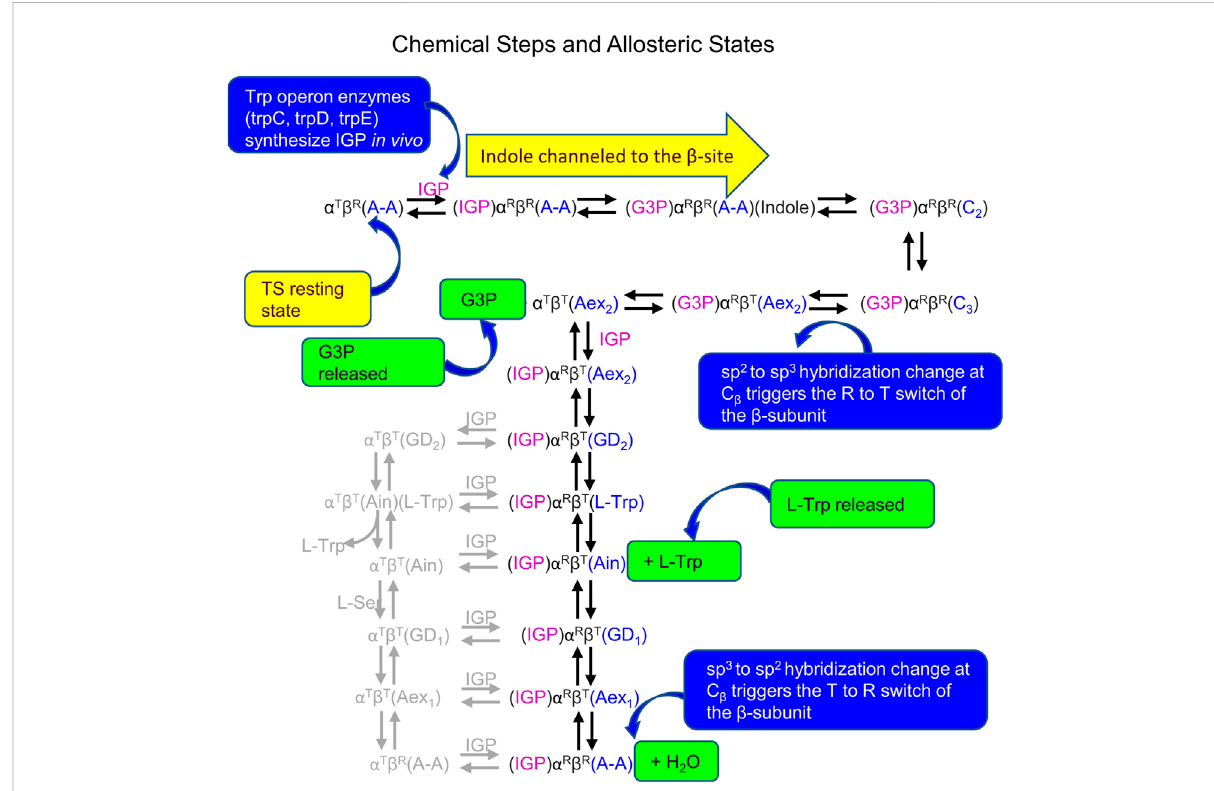
FIGURE 14 Summary ofChemical statesandallostericstatesproposed fortheallostericregulationofL-Trpsynthesis invivo byTS.Owingtothesimilarities ofthe energies of theTand R states, several ofthe chemical intermediates likely have comparableenergies.Minorspecies thought to bepresent are shown in gray. The binding and release of substrates and products occur via the T state subunit